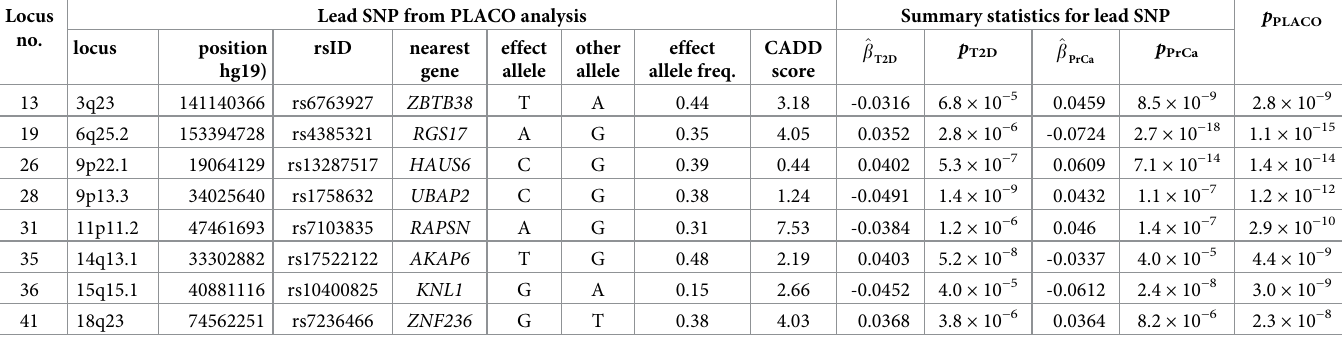
þ PP � 0 : 9 and PP = PP � 3 ) of being causal for both T2D and PrCa 3 4 4 3